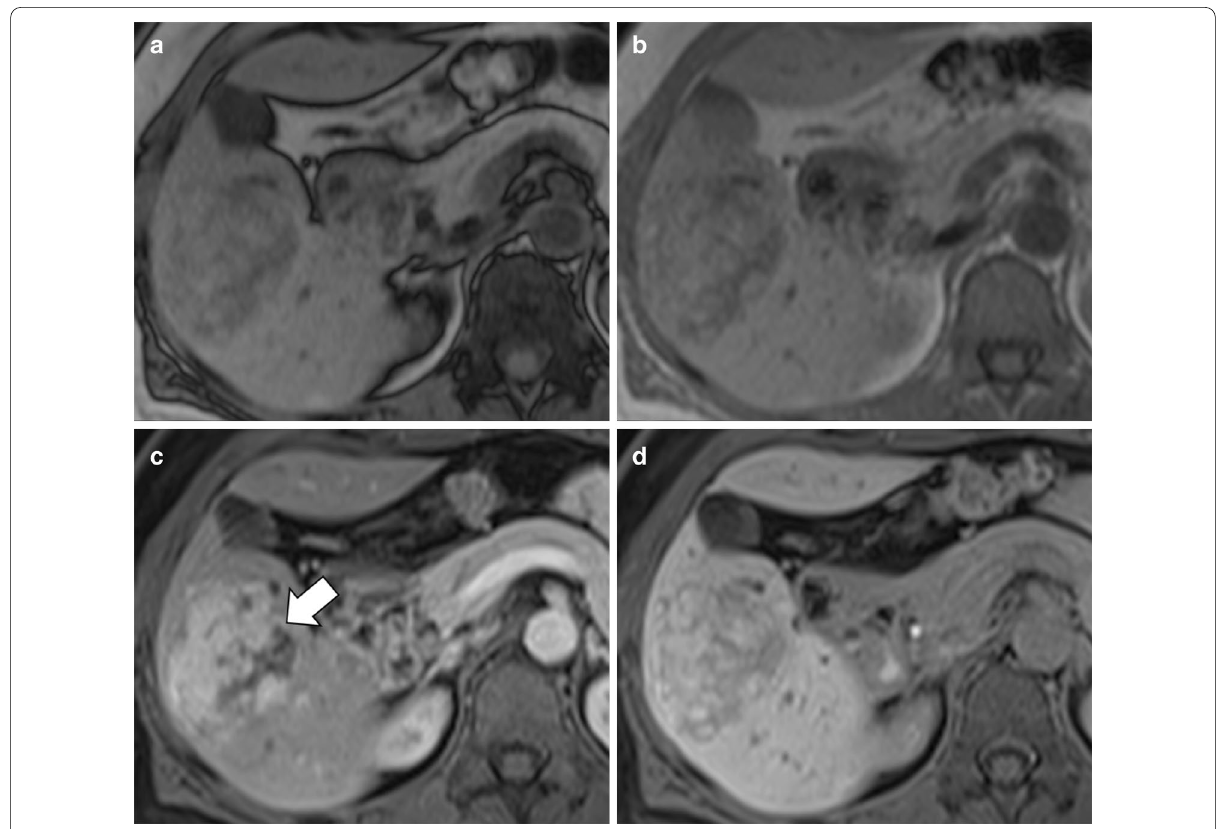
Fig. 4 A 46‑year‑old woman with clinical history of oral contraceptive use and pathology‑proven hepatocellular adenoma. Gadoxetate disodium‑enhanced MRI shows a normal liver characterized by ( a ) no significant signal drop of hepatic parenchyma in the opposed phase compared to ( b ) the in‑phase and ( c ) a hepatocellular adenoma (arrow) that shows contrast enhancement in the arterial phase and ( d ) heterogeneous hyperintensity in the hepatobiliary phase